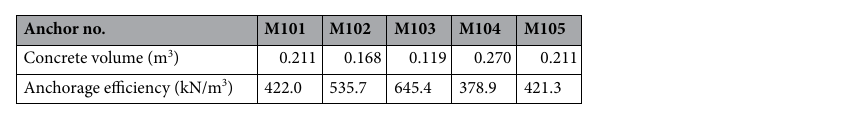
Table 4. Anchorage efficiency of group M1.